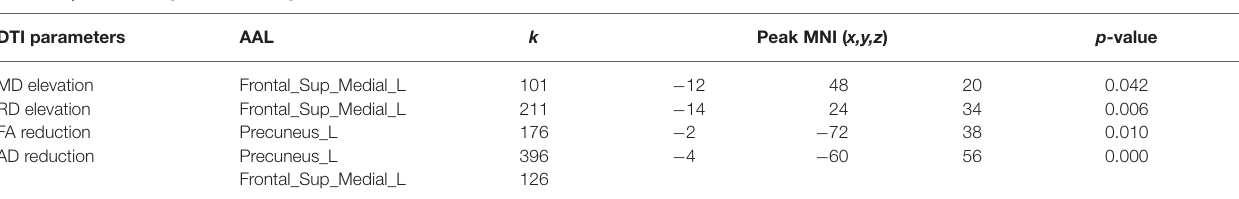
TABLE 2 | Areas of significant change in DTI